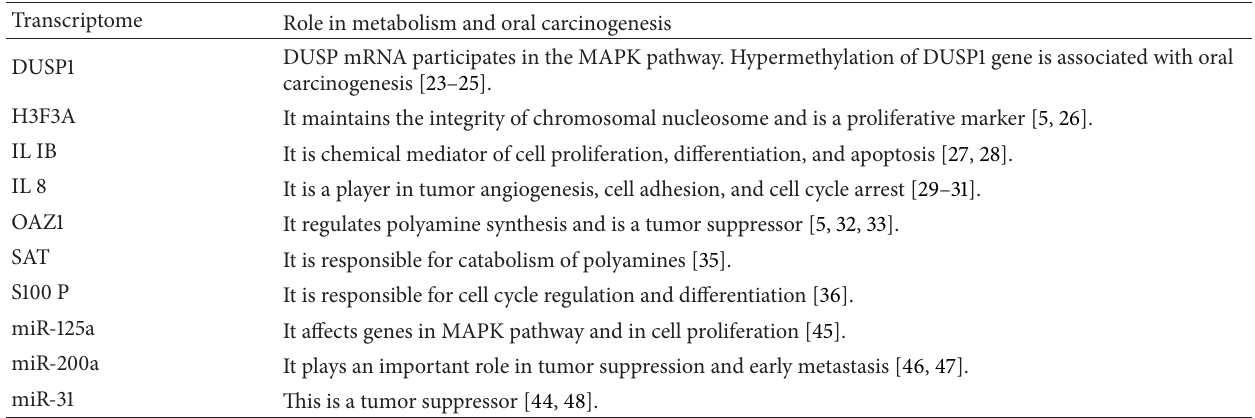
Table 1: Various salivary transcriptomes and their role in oral carcinogenesis.